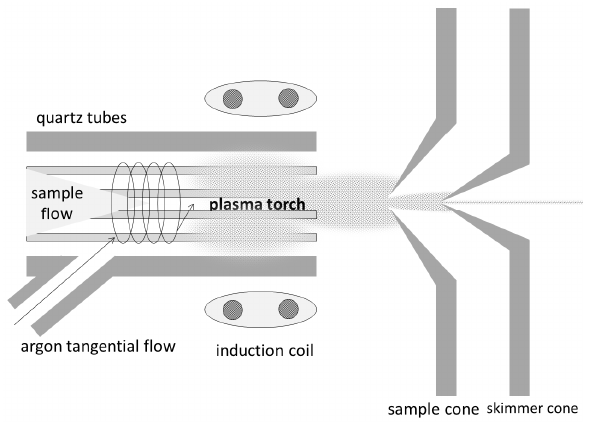
Figure 6. Plasma unit and torch in ICP ‐ MS (adapted from [70–72]).